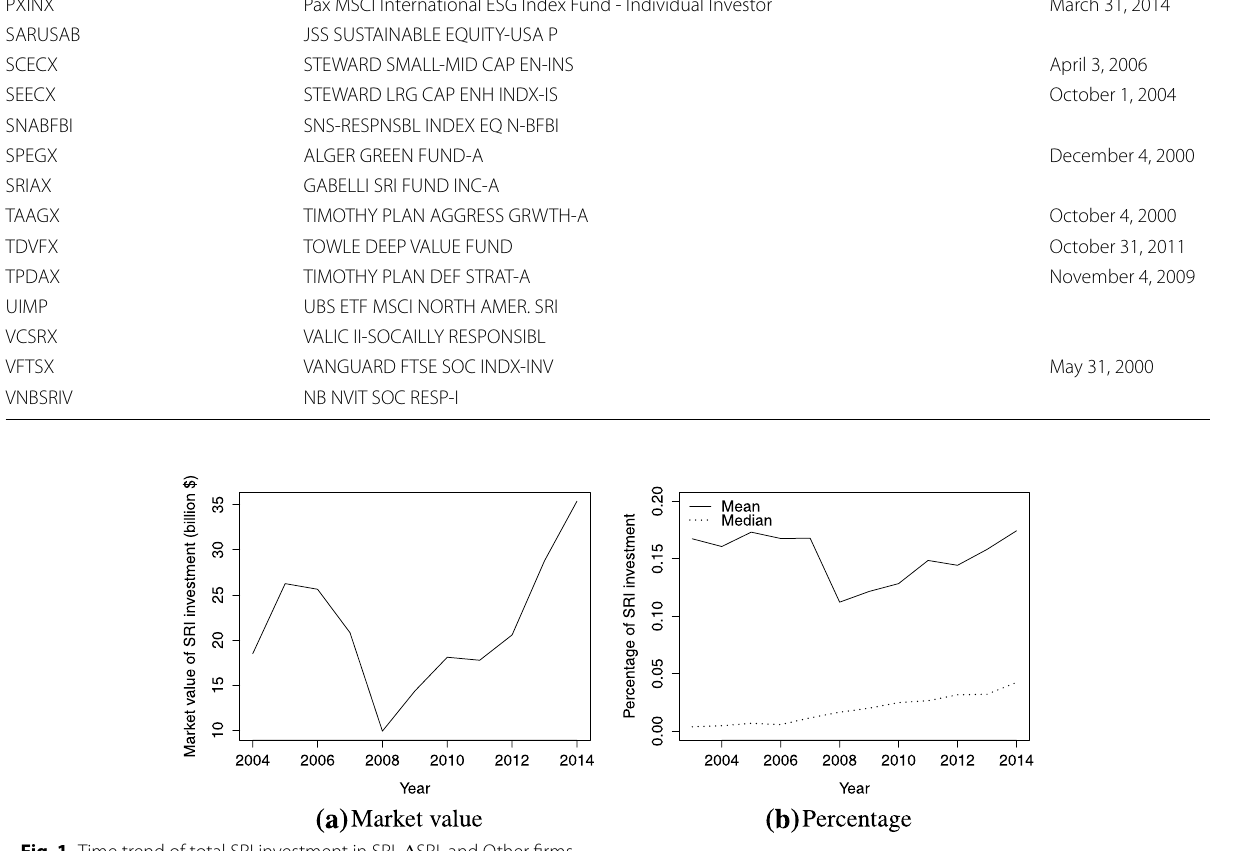
Fig. 1 Time trend of total SRI investment in SRI, (cid:31) SRI, and Other